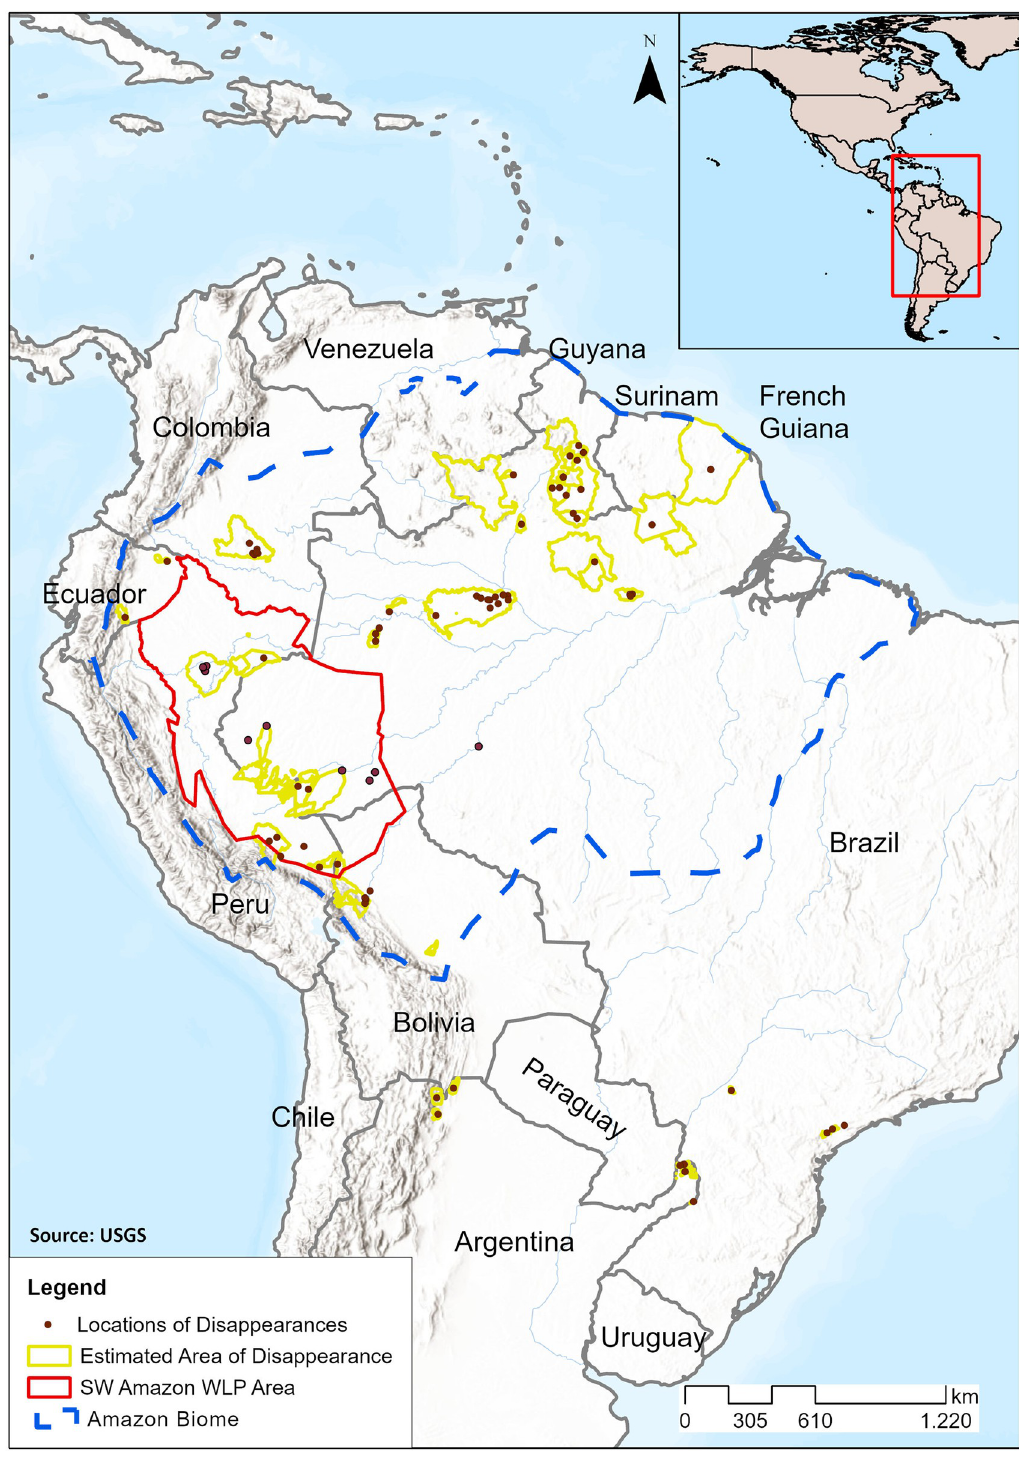
Fig 1. Locations of white-lipped peccary ( Tayassu pecari ) disappearances. Brown dots mark disappearances of small or unknown areal extent. Yellow lines mark the estimated extent for disappearances over larger regions. The 686-million ha western Amazon region, the source area for pelt and hunting data, is delineated in red. The blue line demarcates the Amazon biome. The disappearance site in Guatemala is not shown. Base map provided by the United States Geological Survey (USGS).